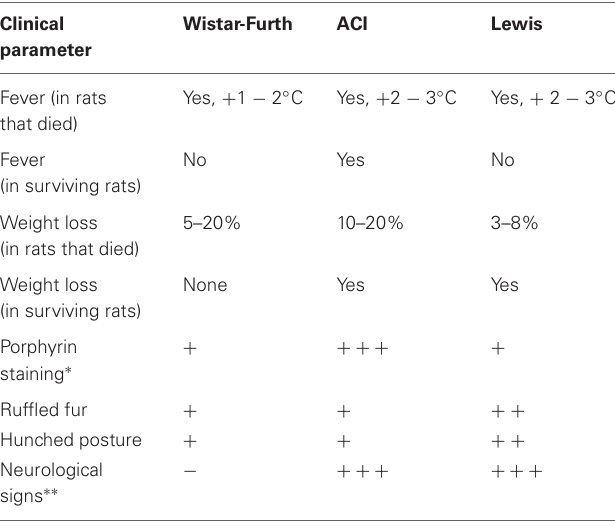
Table 2 | Relative comparison of clinical signs in rat strains after aerosol exposure to